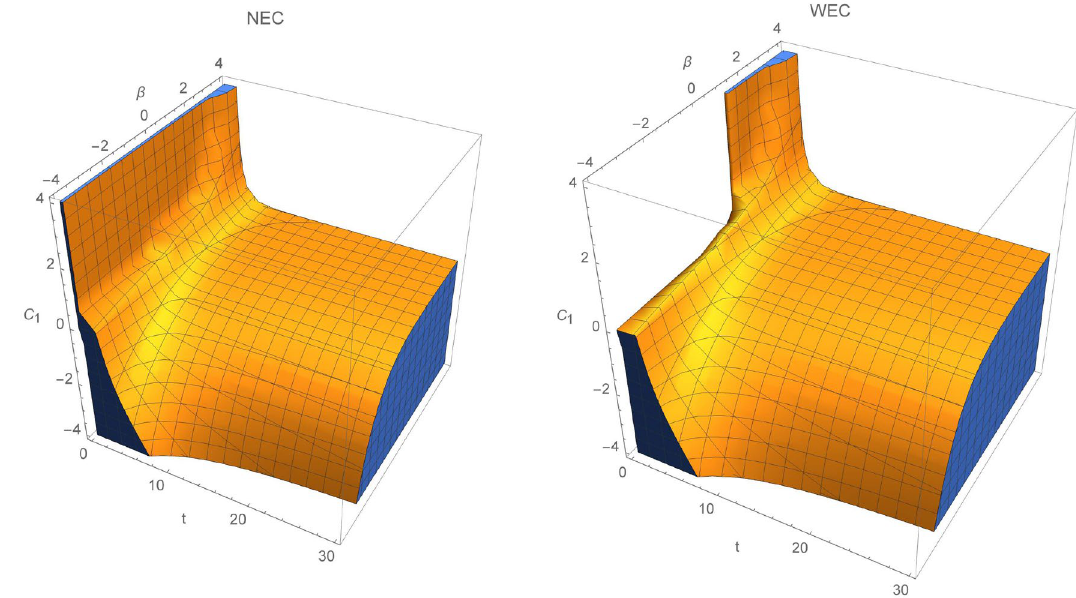
Figure 6. Regions where NEC and WEC are valid for C 2